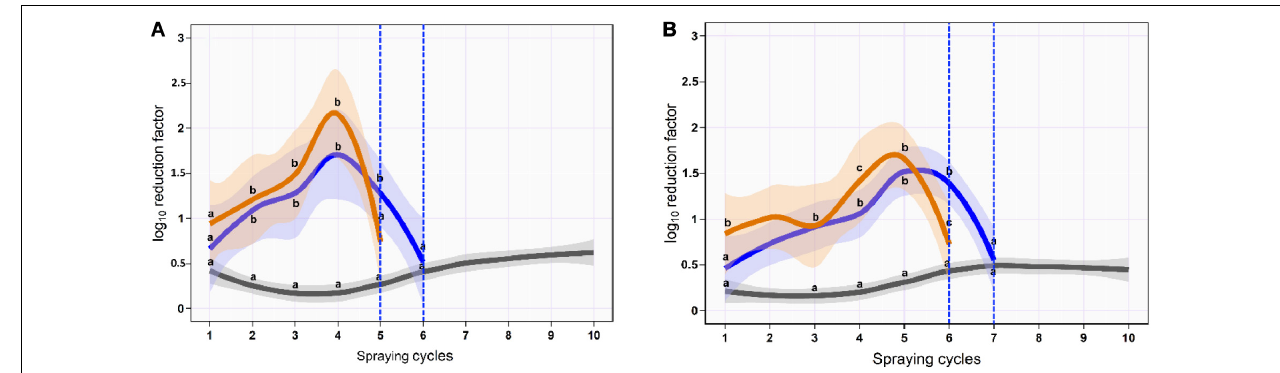
FIGURE 4 | Mean and 95% CI of the log 10 reduction in Salmonella typhimurium – choleraesuis (aSTC) cell count on skin surface (A) and subcutaneous (B) of drumstick sprayed with distilled water (gray), ozone of 8 ppm (blue), and ozone–lactic acid blend (orange) using multi-sequential spraying approach. The vertical dashed blue line indicates that no aSTC was detected.